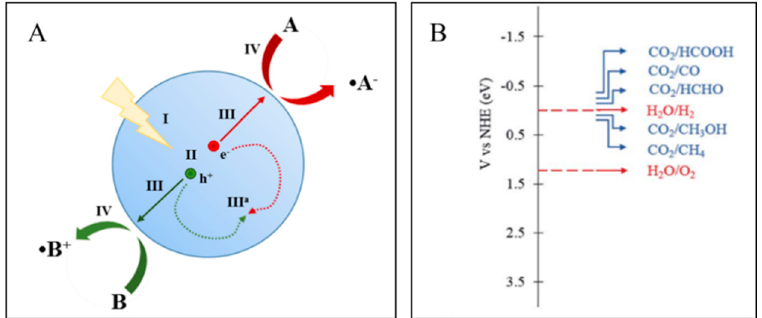
Figure 2. ( A ) Steps in photocatalytic reaction process: (I) light absorption, (II) separation of photogenerated charges, (III) transfer of electrons and holes, (III) eventual recombination of charges; (IV) redox reactions where A and B mean chemicals in reductive and oxidative reactions, respectively. ( B ) Energy levels of the important photocatalytic reactions with respect to normal hydrogen electrode NHE at pH = 0.